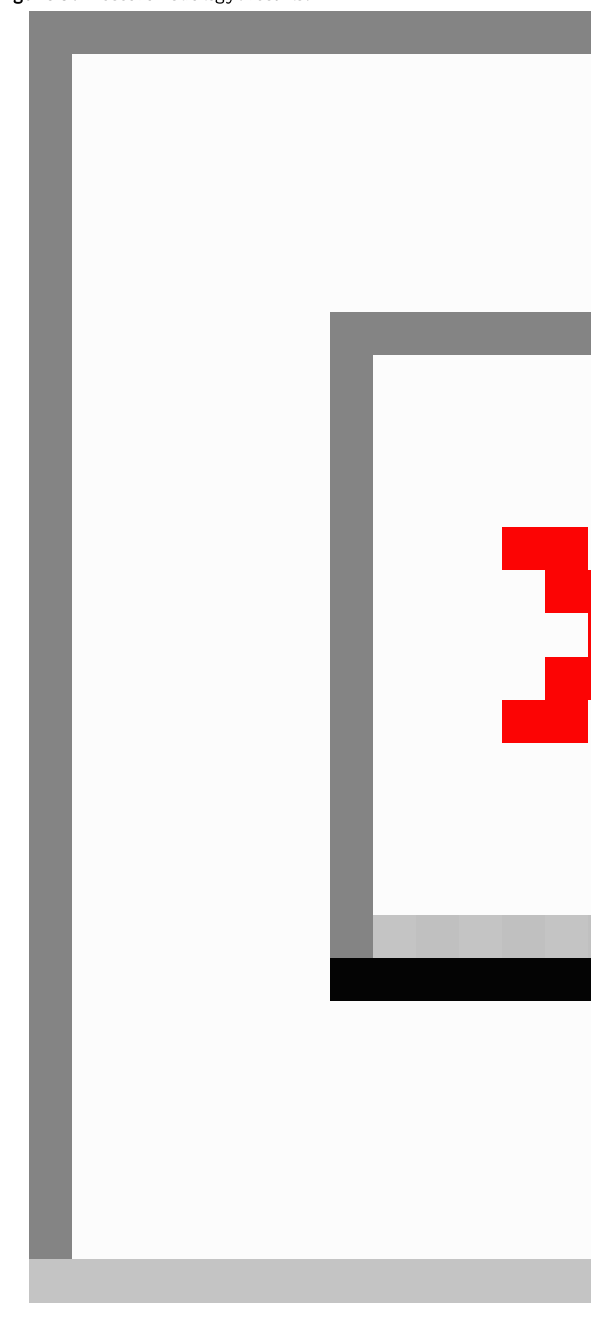
Figure 3. Research strategy: